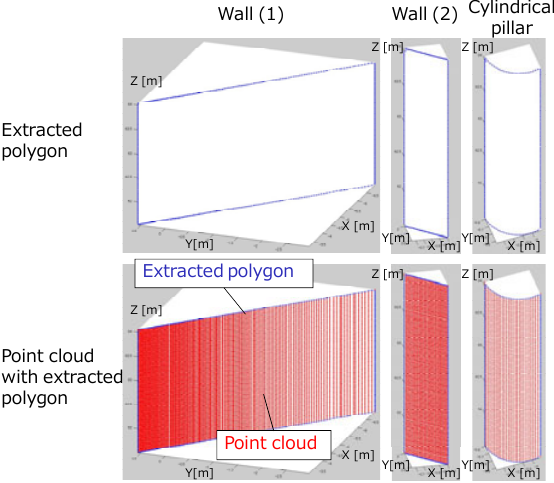
Figure 13. Parts of results of polygon extraction from point